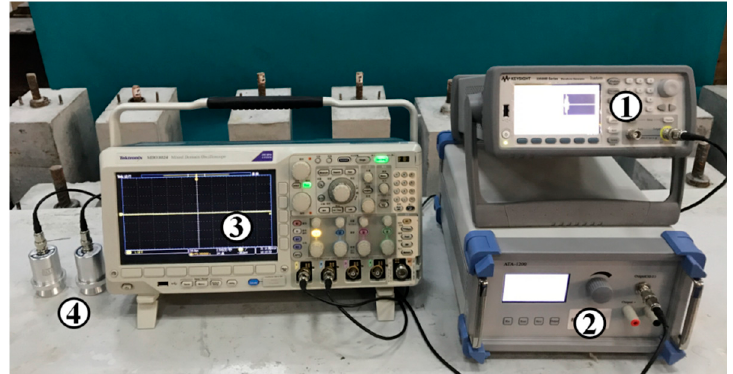
Figure 3. The schematic diagram of the detecting system.